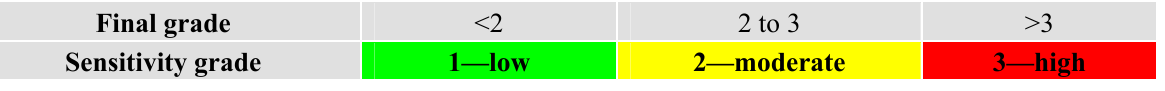
Table 7. Final assessment sentitivity B.